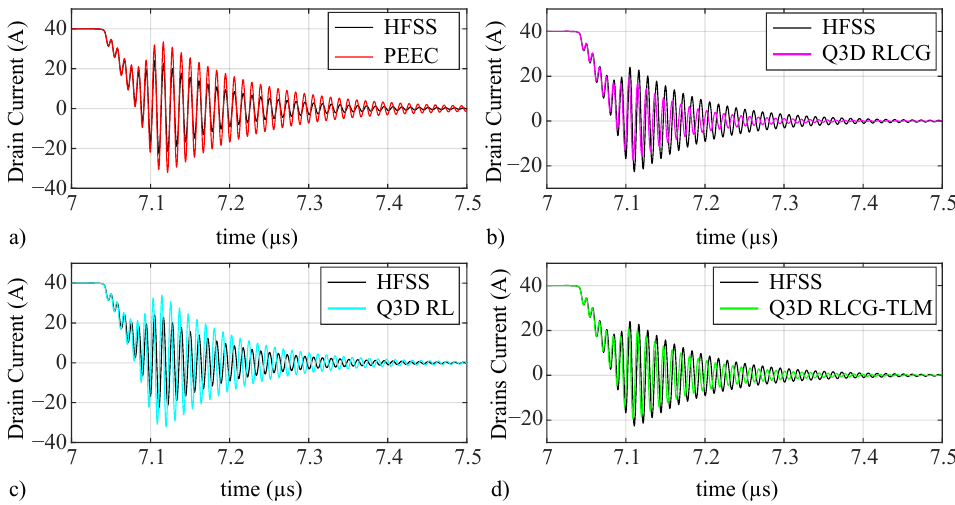
Figure 7. Simulations of HF oscillations observed in the drain current waveform of a SiC trench power MOSFET M DUT2 for I L = 40 A, V test = 600 V, R gate = 1 Ω , C gd,ext = 1 pF using the extracted 6 × 6 S-parameters: ( a ) HFSS vs. PEEC, ( b ) HFSS vs. Q3D RLCG, ( c ) HFSS vs. Q3D RL, and ( d ) HFSS vs. Q3D